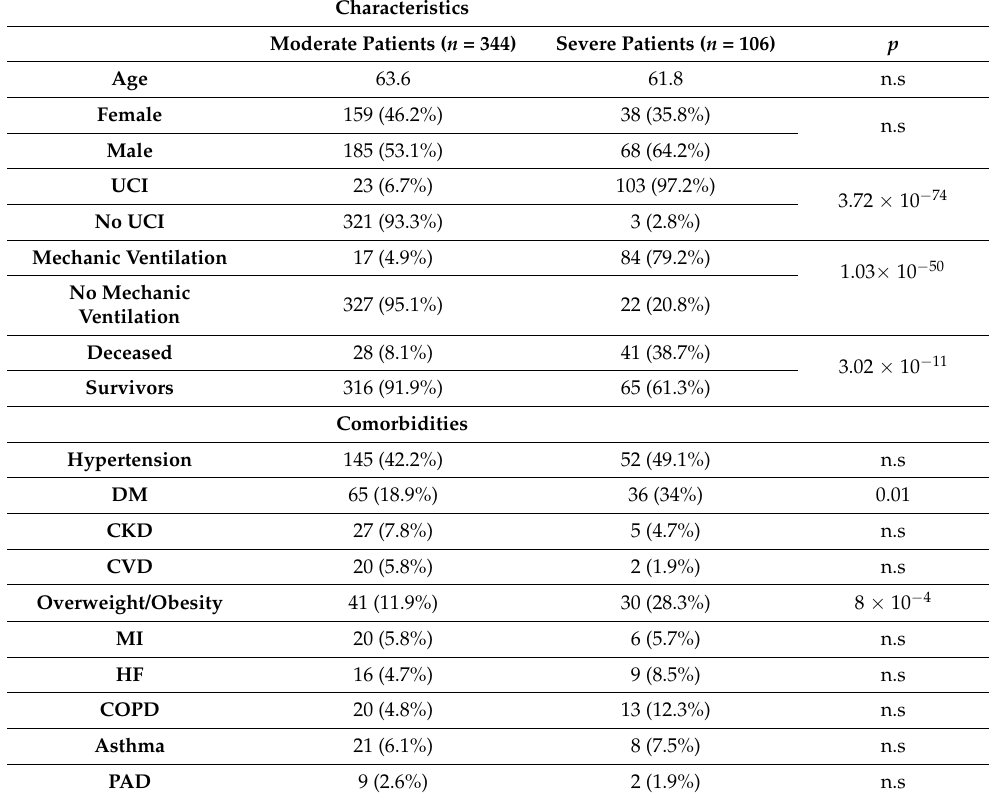
Table 3. Characteristics and comorbidities of the study